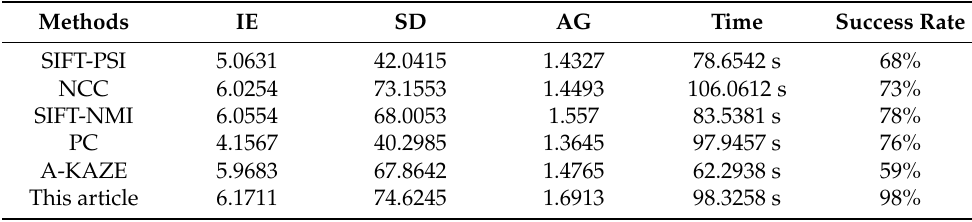
Table 1. Different stitching algorithms quality evaluation